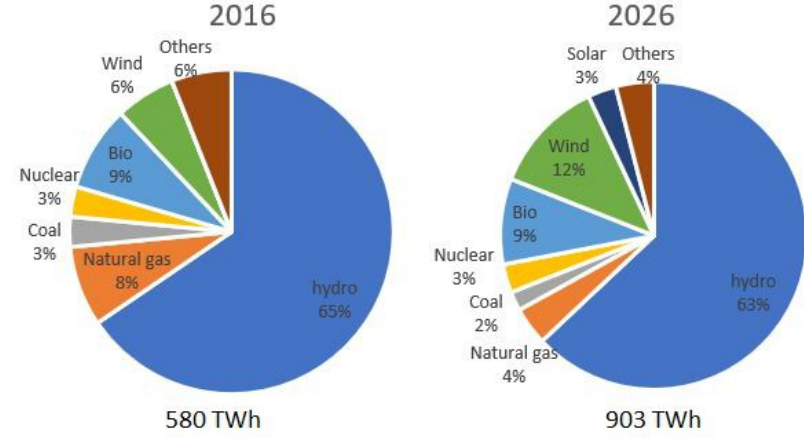
Figure 5. Evolution of the Brazilian electrical matrix installed capacity by generation source. Data were sourced from Reference [18].